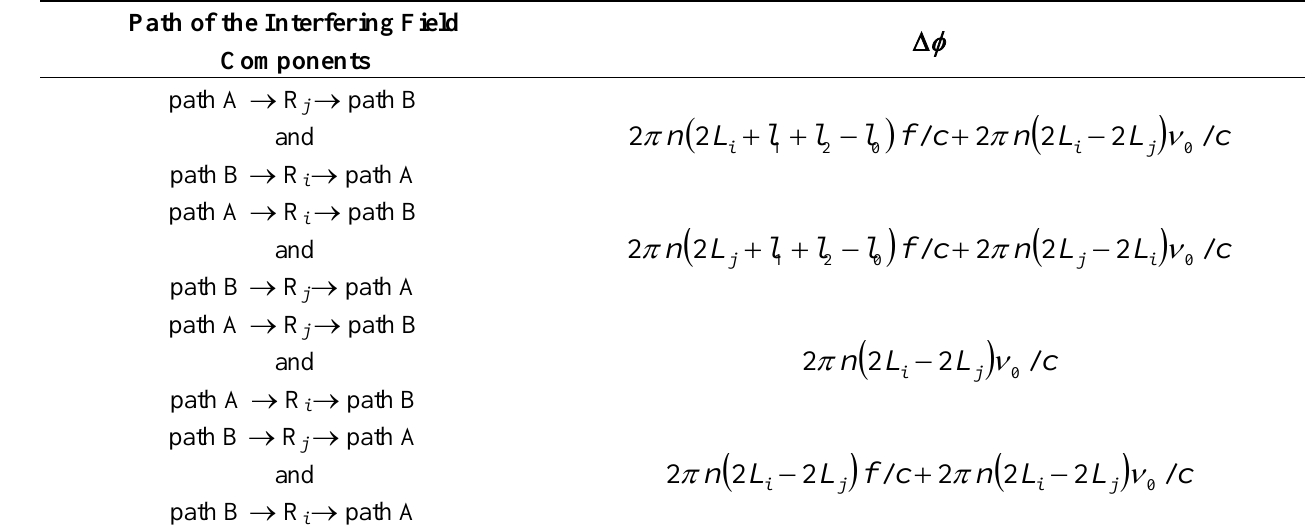
Table 1. Contributions of interference caused by undesirable reflections for a linear frequency-shifted Sagnac interferometer system [33]. With reference to Figure 3, path A is the fiber section between the two couplers that does not have the frequency shifter, whereas path B is the other fiber section that contains the frequency